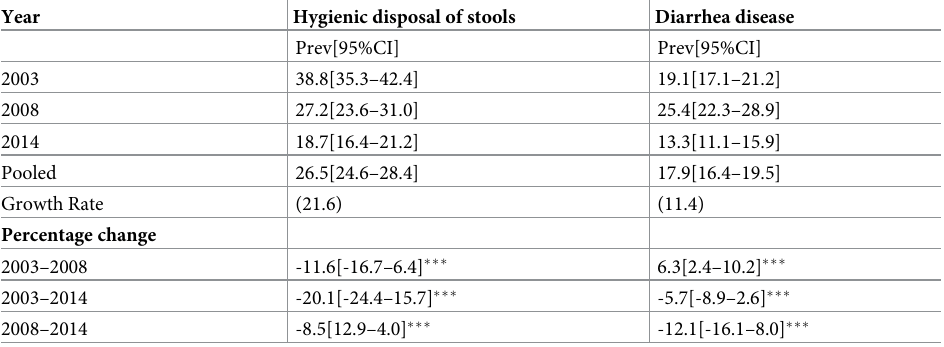
Table 1. Prevalence and percentage change in access to hygienic disposal of stools and diarrhea diseases among women with children under two years in Ghana, GDHS